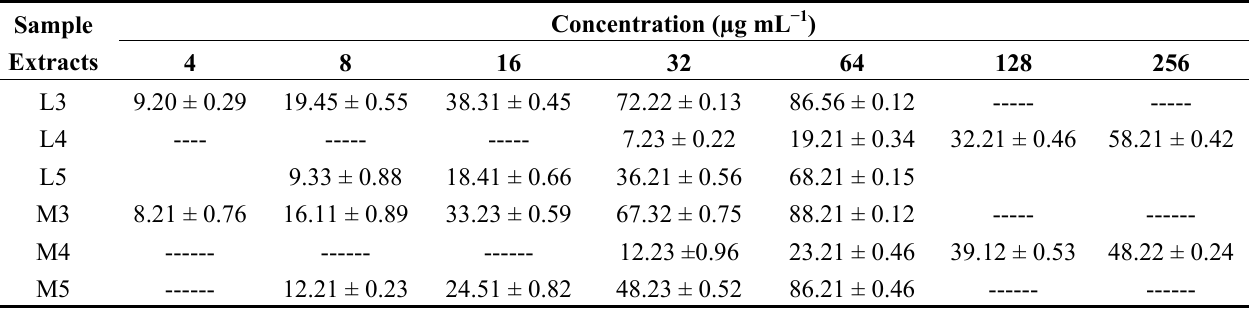
Table 4. % Urease inhibitory activity (MIC) of plant extracts showing potent anti- H. pylori potential.